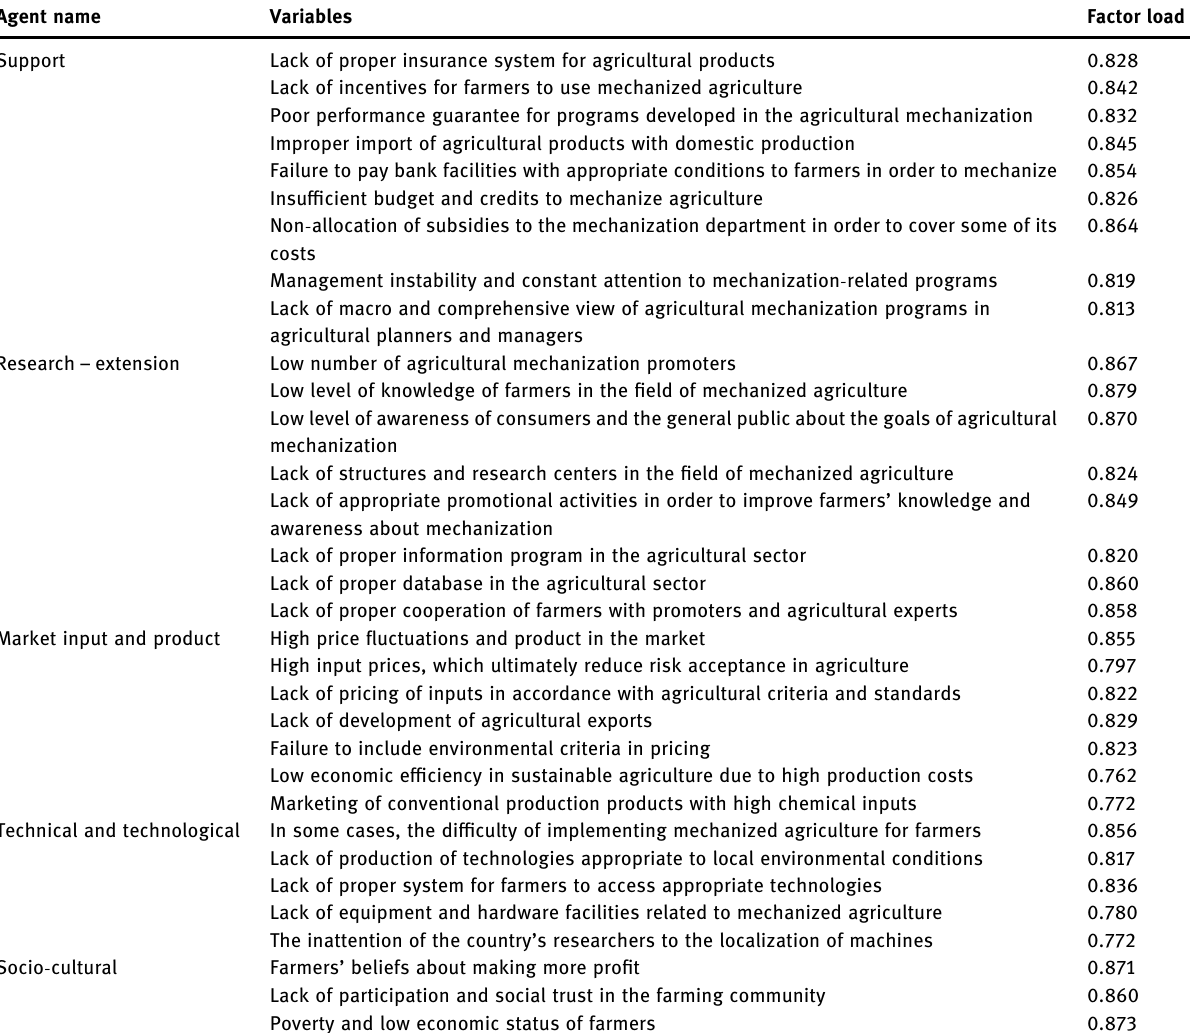
Table 6: Items related to each of factors and the amount of coe ffi cients obtained from the rotated matrix Agent